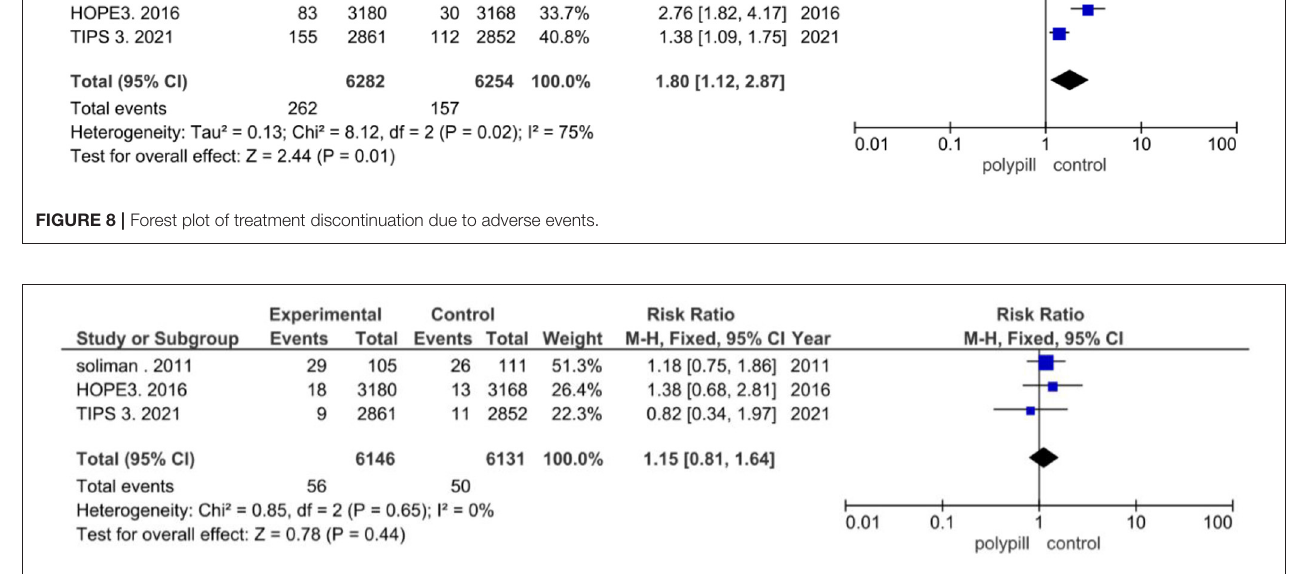
FIGURE 9 | Forest plot of